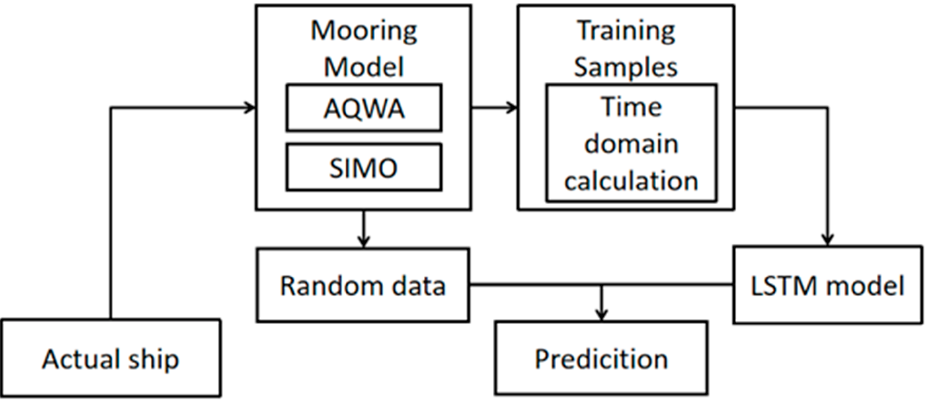
Figure 1. General framework of mooring line tension prediction.